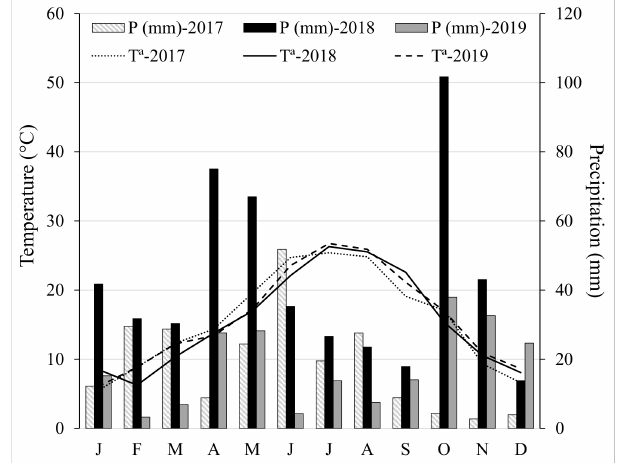
Figure 1. Mean values of temperature and rainfall registered in Alcañiz (Teruel) during three consecutive crop seasons (2017, 2018, and 2019). J: January; F: February; M: March; A: April; M: May; J: June; J: July; A: August; S: September; O: October; N: November; D: